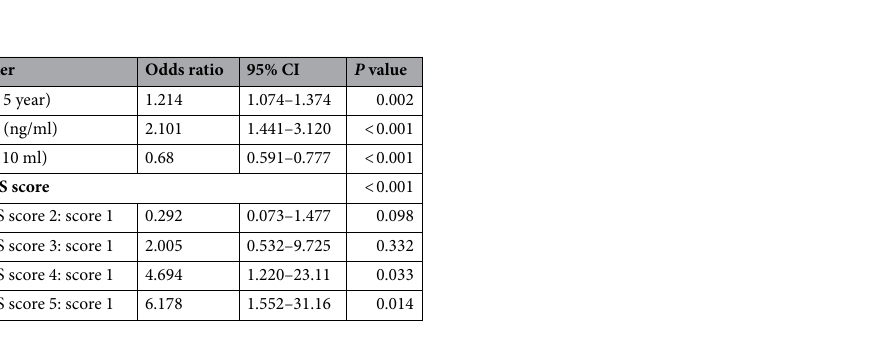
Table 2. Multivariate logistic regression model analysis for the prediction of sPC. CI confidence interval, PI-RADS prostate imaging reporting and data system, PSA prostate-specific antigen, PV prostate volume, sPC clinically significant prostate